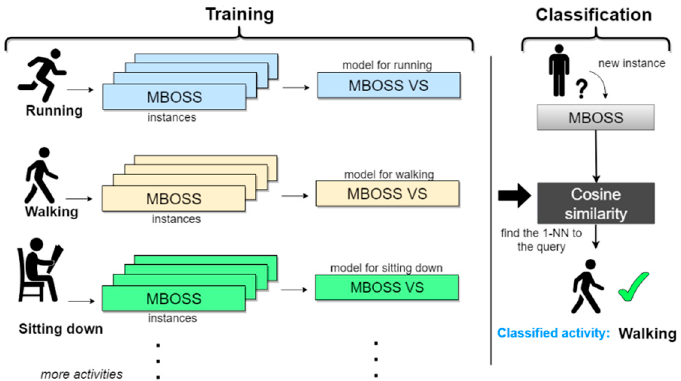
Figure 5. MBOSS VS classifier based on the vector space model to classify human activities.